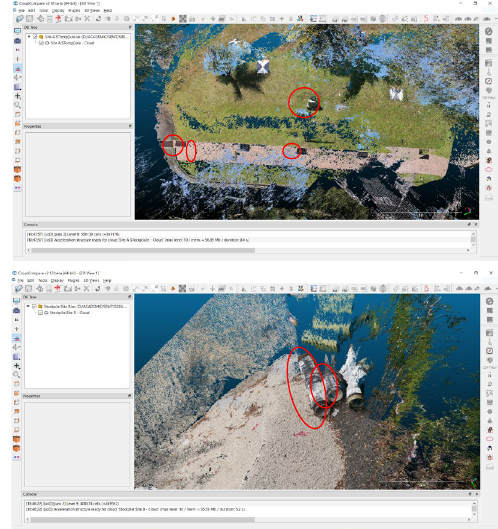
Figure 4.2. Man-made features selected for dimensional validation for site A (top) and site B (bottom) From the table, there are significant differences between the distance measured. The differences increase as the distance measured increase because the entire smartphone SFM point cloud model is proven to be larger than TLS generated point cloud model, referring above. The RMSE computed indicates that the standard deviation of the differences between Smartphone SFM and TLS generated point cloud is 0.310